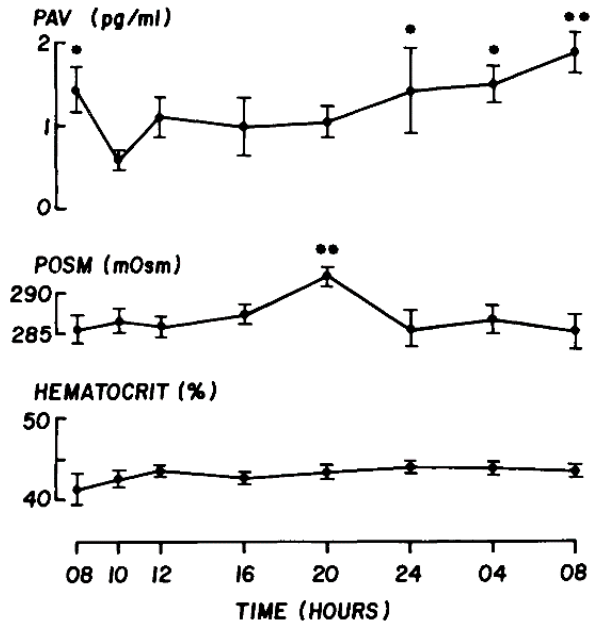
Figure 5. Mean values ( ± SE) of plasma arginine vasopressin (PAV), plasma osmolality, and hematocrit over 10 diurnal cycles, in 8 healthy males, age 21–28 years. * p < 0.05; ** p < 0.01. (Reprinted with permission from ref. [166]. Copyright 2021 Oxford University Press)